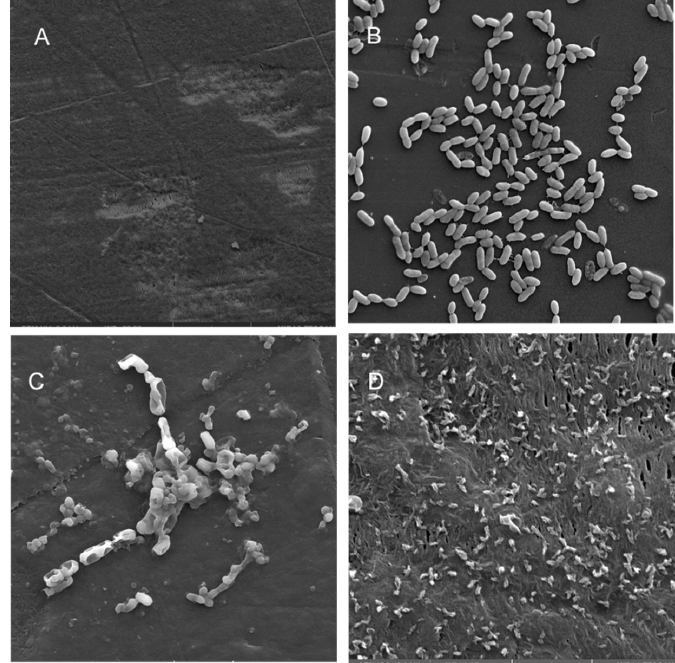
Figure 5. Scanning electron micrographs ( A ) of un ‐ colonized PE (×4980); ( B – D ) of A. hydrophila in the planktonic phase (×6470), adherent phase on PE (×15,900) and biofilm phase induced on PE pressed on blood agar (×19,700), respectively.